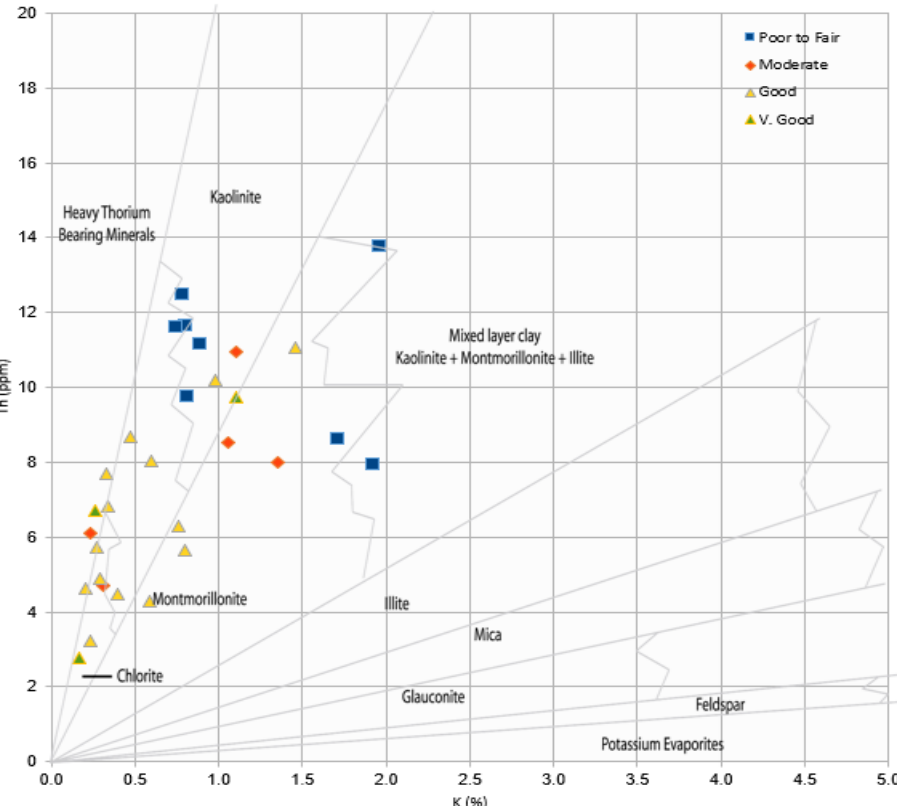
Figure 25. Thorium/potassium cross-plot showing the different classes of permeability and clay minerals type associated with them (modified after [24]).